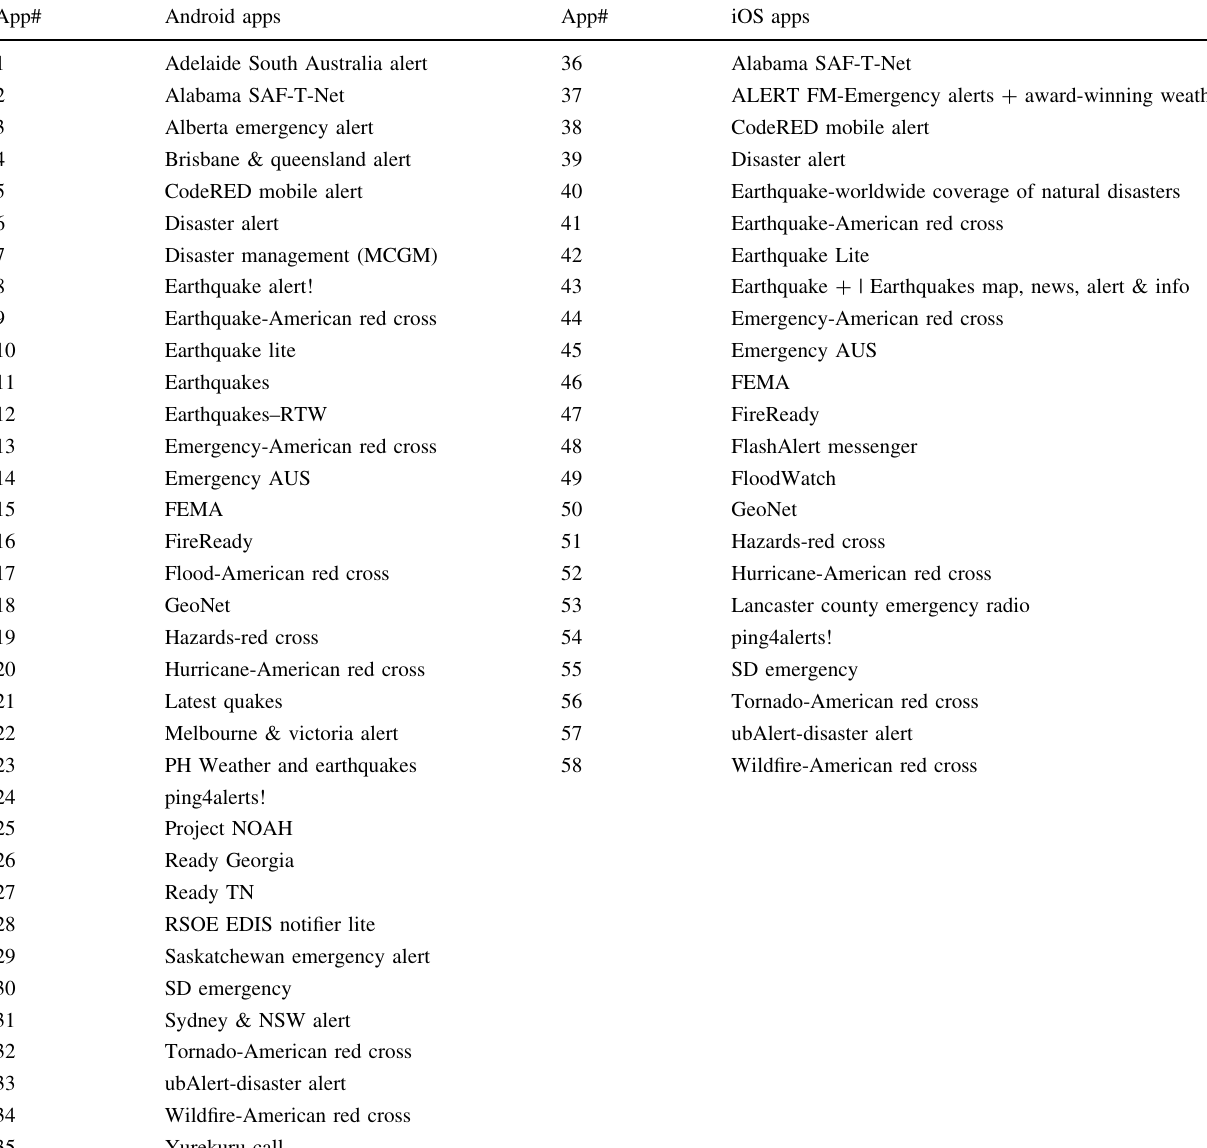
Table 2 List of apps included in the